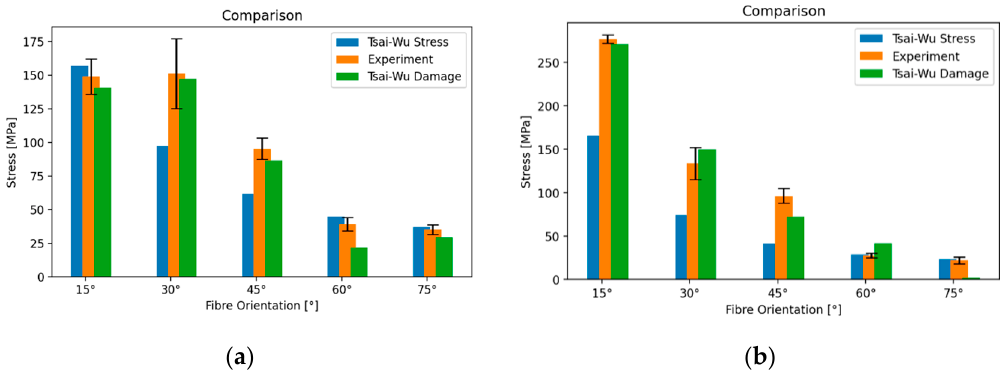
Figure 14. Comparison of the failure stress values between the tensile test and the predicted